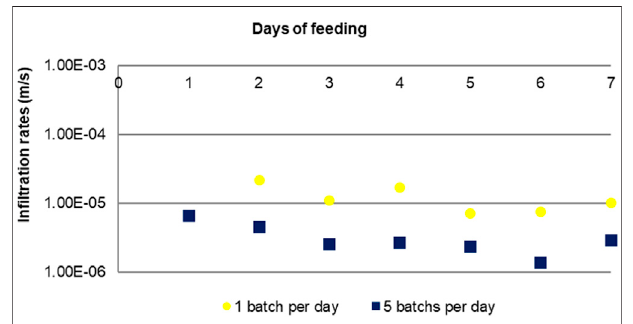
FIGURE 9 | Effects of fractionation of the HL on in fi ltration rates.